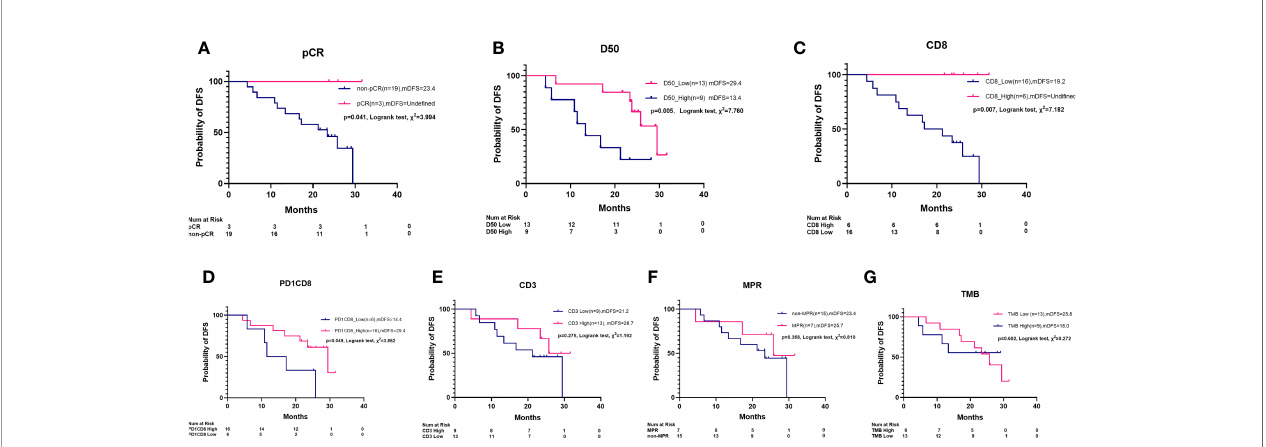
FIGURE 5 | Kaplan – Meier survival plot of disease-free survival by pCR, MPR, TCR D50, PD1 + CD8 + cells, CD3 + cells, CD8 + cells, and TMB. (A) pCR patients had a longer median disease-free survival (mDFS) than non-pCR patients (NR vs. 23.4 m, Log rank test, c 2 = 3.994, p = 0.041). (B) A longer mDFS was observed in patients with high TCR clonality than those with low TCR clonality (29.4 m vs. 13.4 m, Log rank test, c 2 = 6.660, p = 0.009). (C) A longer mDFS was observed in patients with high-level CD8 + cells than those with low-level CD8 + cell (NR vs. 19.2 m, Log rank test, c 2 = 7.182, p = 0.007). (D) A longer mDFS was observed in patients with high- level PD1 + CD8 + cells than those with low level PD1 + CD8 + cells (29.4 m vs. 14.4 m, Log rank test, c 2 = 3.852, p = 0.049). (E) mDFS was numerically but not statistically longer in patients with high-level CD3 + cells than those with low-level CD3 + cells (28.7 m vs. 21.3 m, c 2 = 1.192, p = 0.275). (F) Not statistically different mDFS was found between MPR patients and non-MPR patients (25.7 m vs. 23.4 m, Log rank test, c 2 = 0.810, p = 0.368). (G) Not statistically different mDFS was found between high TMB and low TMB patients (25.8 m vs. 18.0 m, Log rank test, c 2 = 0.272, p =